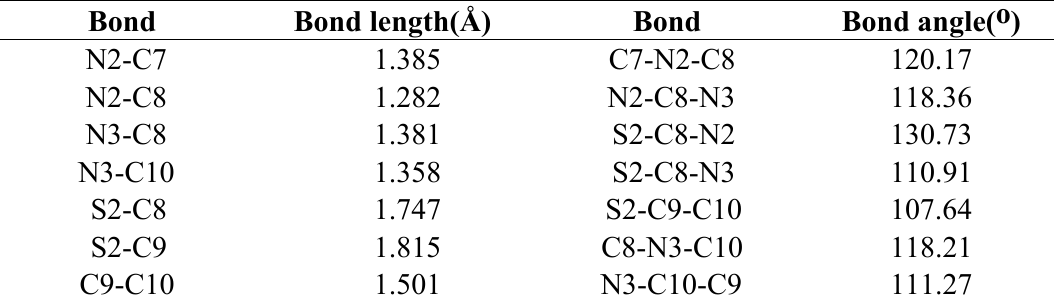
Table 2. Selected bond lengths and bond angles for 3c